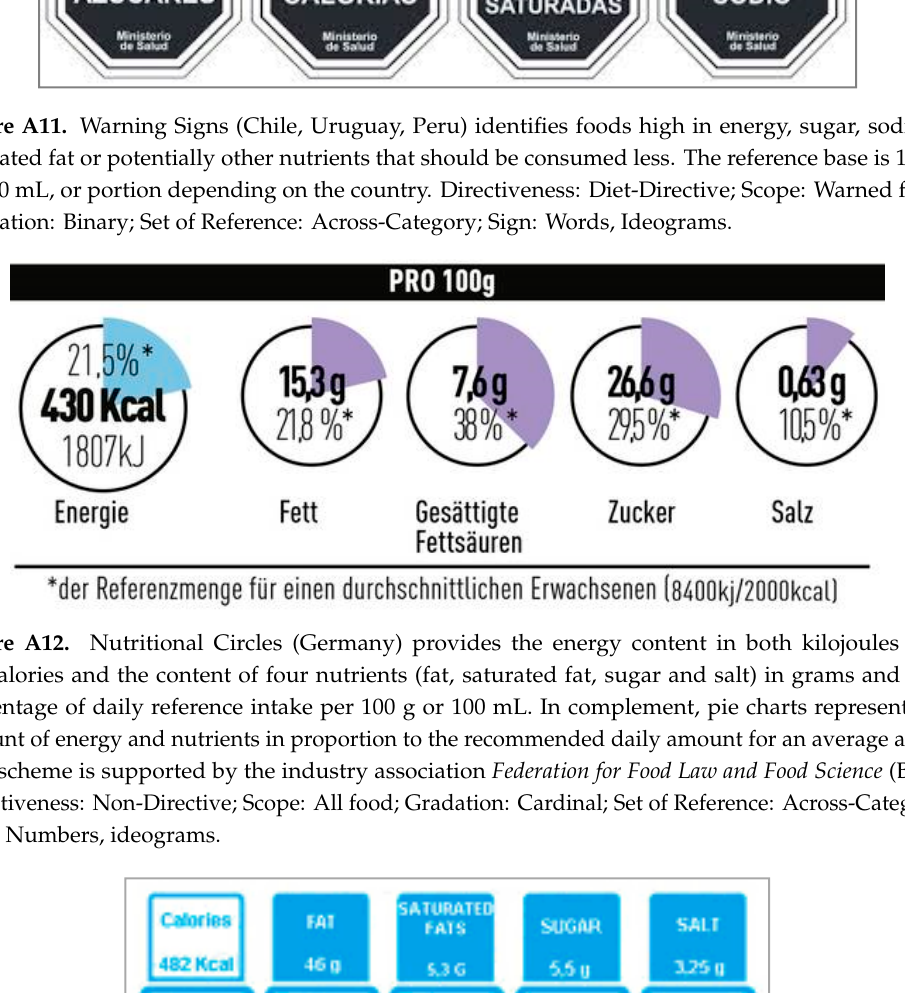
Table A1. The seven prototype FoPLs tested in our study illustrated with the example of the vegetarian pizza.